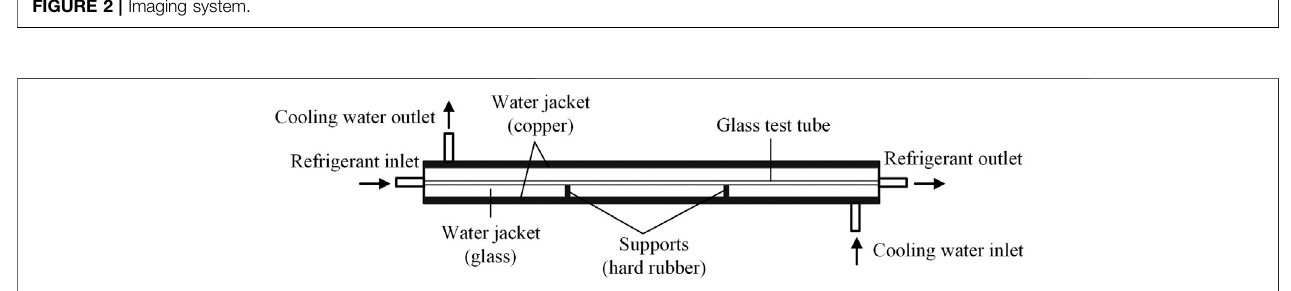
FIGURE 2 | Imaging system.